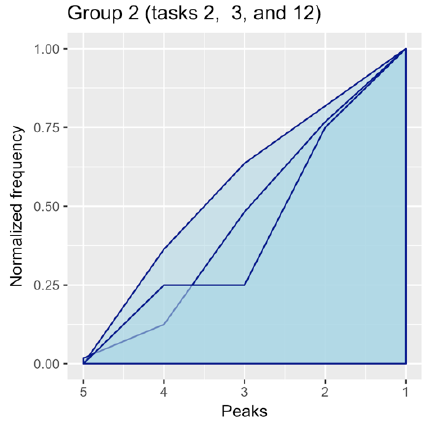
Fig. 11. Group combining learning curve for tasks 6 (View heuristic evaluation form sample) and 16 (Register user). This group sums up to 9 observatios.